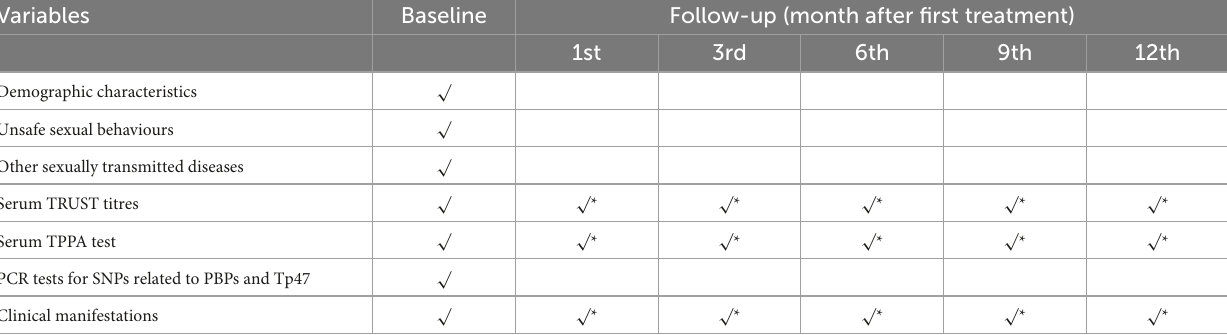
TABLE 1 Information collected at each study time point.